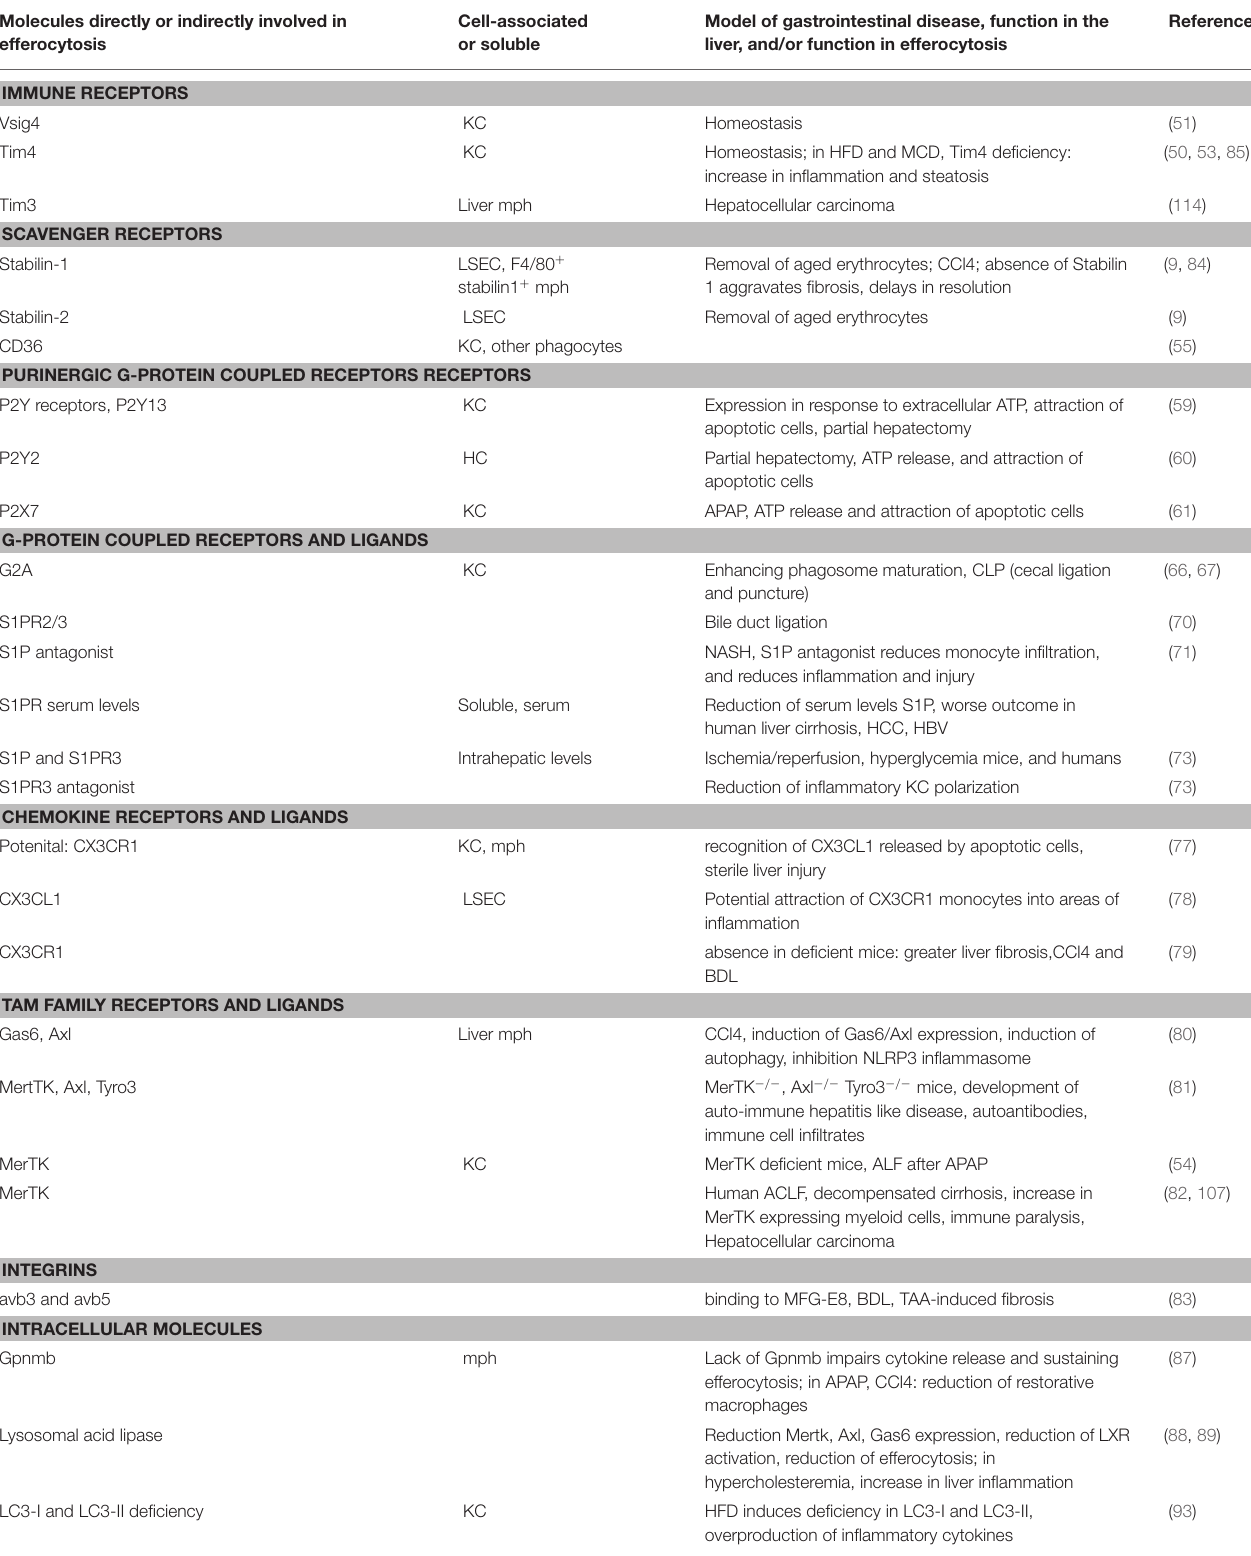
TABLE 1 | Efferocytosis mechanisms in liver disease. Molecules directly or indirectly involved in efferocytosis